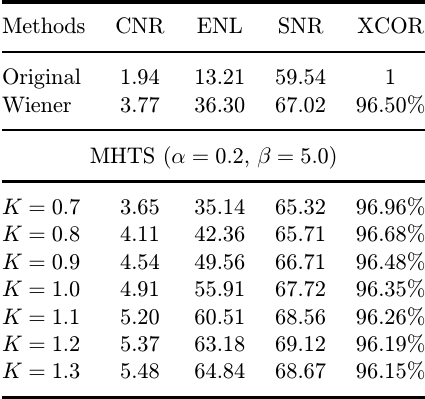
Table 1. Image quality metrics when